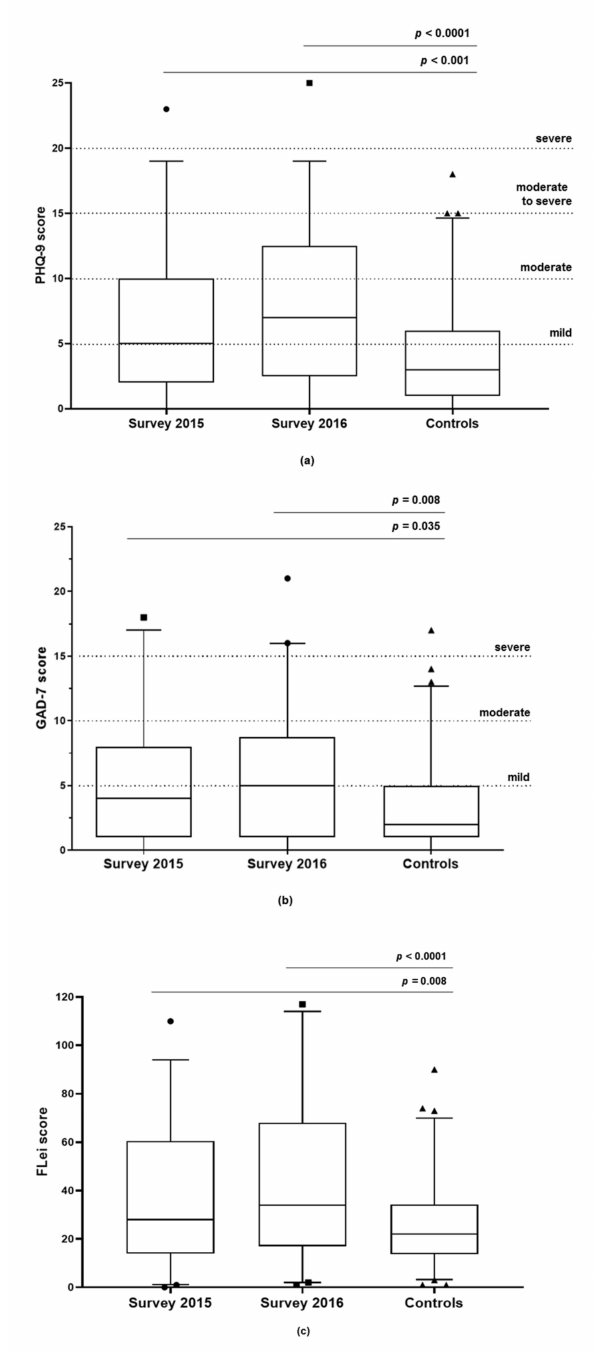
Figure 2. Results of the depression (PHQ-9), anxiety disorder (GAD-7) and cognitive performance (FLei score) questionnaires from the iTTP patients in two surveys (2015 and 2016) and the healthy controls (median, box 25th and 75th percentiles, whiskers 2.5th and 97.5th percentiles, • , (cid:4) , (cid:78) denote outliers above 97.5th percentiles or below 2.5th percentiles outliers). ( a ) PHQ-9: For the first survey ( n = 88), the median evaluated score was 5 (IQR 2–10), for the second survey ( n = 81), the median score was 7 (IQR 2.5–12.5), and for the healthy controls, the median score was 3 (IQR 1–6). ( b ) GAD-7: For the first survey ( n = 87), the median evaluated score was 4 (IQR 1–8), for the second survey ( n = 80), the median score was 5 (IQR 1–8.75), and for the healthy controls ( n = 131), the median score was 2 (IQR 1–5). ( c ) FLei: For the first survey ( n = 85), the median evaluated score was 28.0 (IQR 14–60.5), for the second survey ( n = 81), the median score was 34.0 (IQR 17–68), and for the healthy controls ( n = 130), the median score was 22.0 (IQR